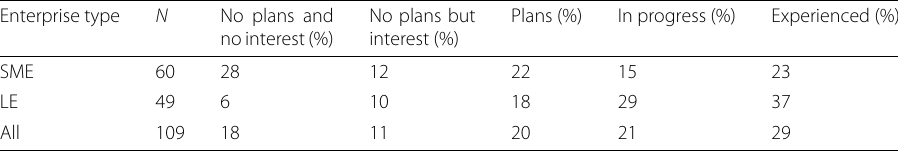
Table 5 Interest and engagement in developing IoT applications separated by enterprise type Enterprise